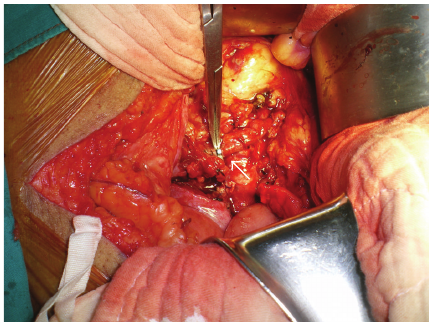
Figure 4: The right ureterotomy was done and the double J stent was inserted